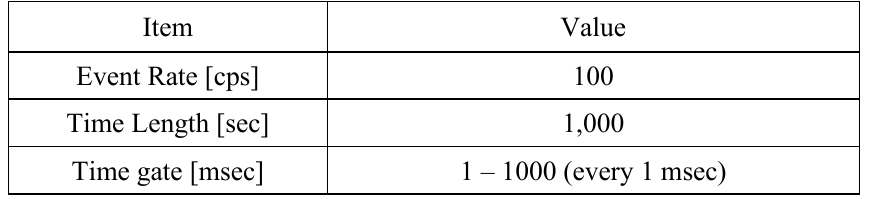
Table I. Parameters of the Poisson Event’s